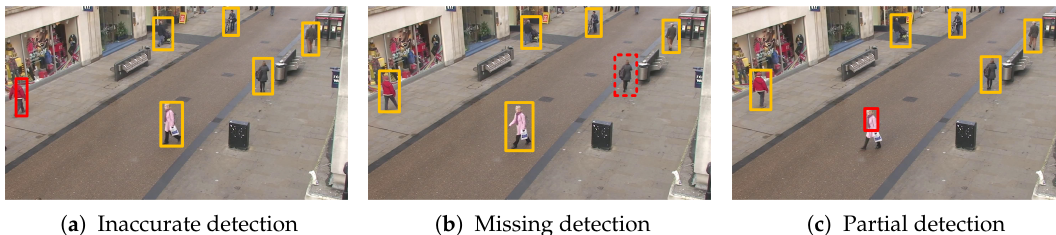
Figure 1. Illustrations of detection failures in three consecutive frames. The solid yellow bounding boxes represent the correct detection responses, and the red boxes are error cases. ( a ) The red bounding box is a deviation detection that does not exactly match the target. ( b ) The red dashed bounding box indicates a missing detection. ( c ) The detection response only includes the upper body of the